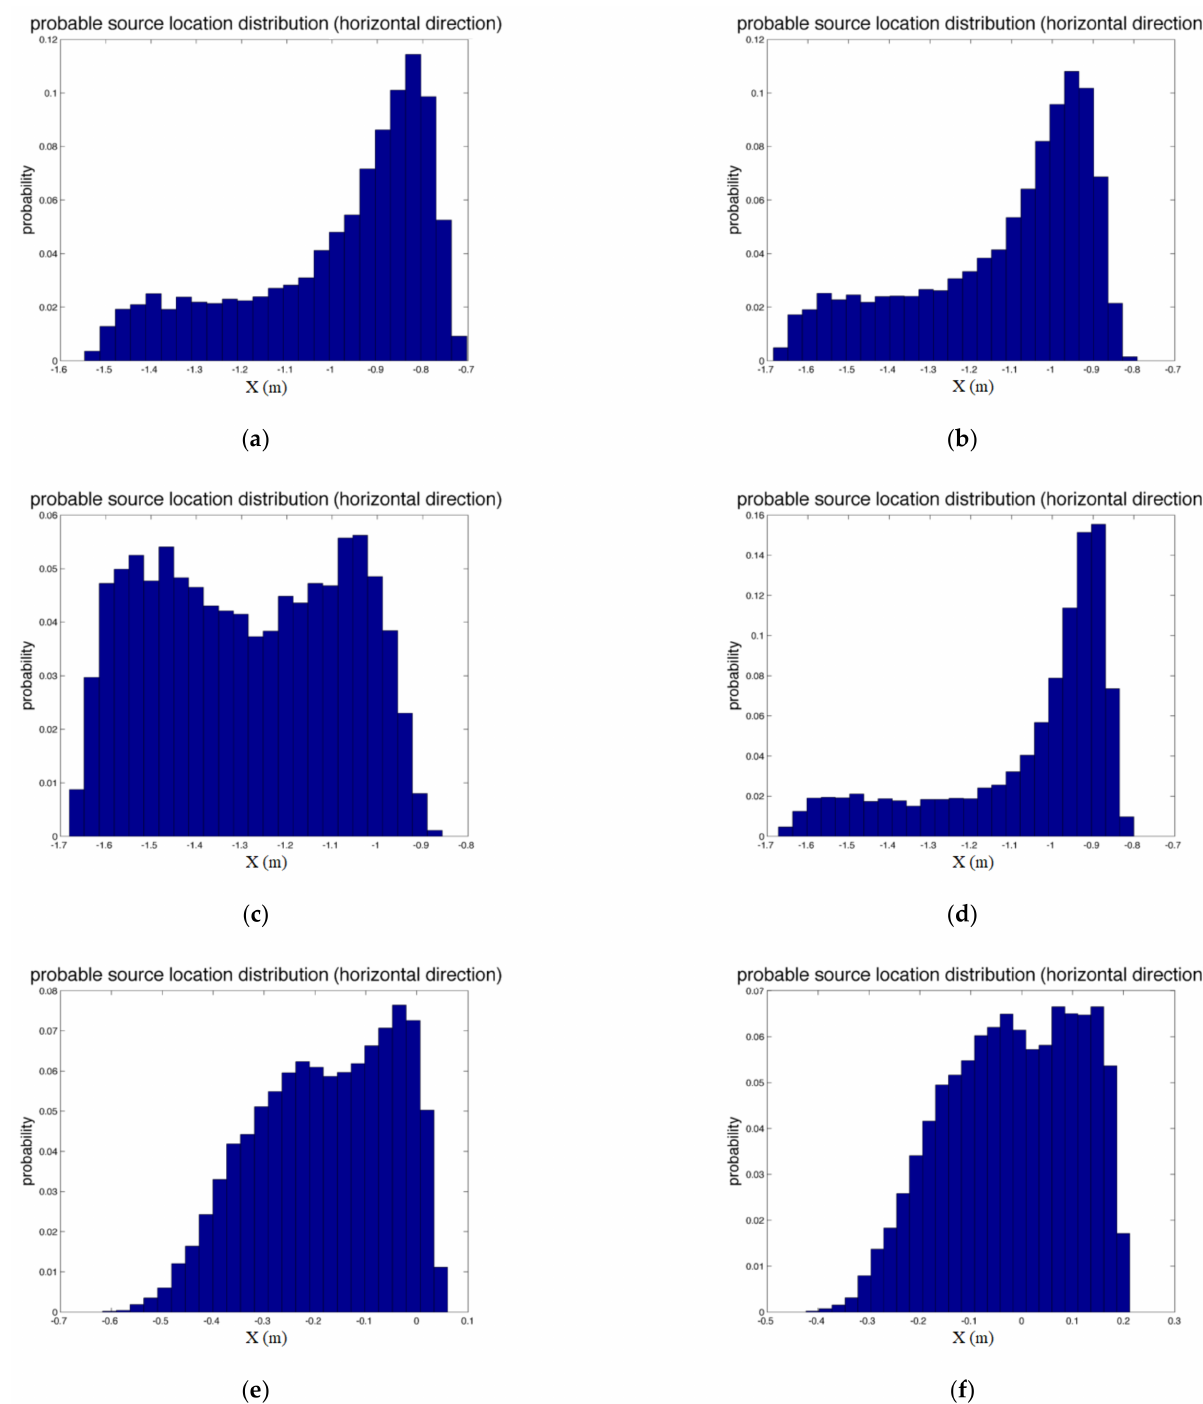
Figure 4. Final probable particle location distribution in the x-direction: ( a ) final probable source location distribution in backward tracking tests with the diffusivity of Rouse [37], using the explicit method; ( b ) final probable source location distribution in backward tracking tests with the diffusivity of Rouse [37], using the implicit method; ( c ) final probable source location distribution in backward tracking tests with the diffusivity of Absi et al. [38], using the explicit method; ( d ) final probable source location distribution in backward tracking tests with the diffusivity of Absi et al. [38], using the implicit method; ( e ) final particle location distribution in forward tracking tests with the diffusivity of Rouse [37], using the explicit method; ( f ) final particle location distribution in forward tracking tests with the diffusivity of Absi et al. [38], using the explicit